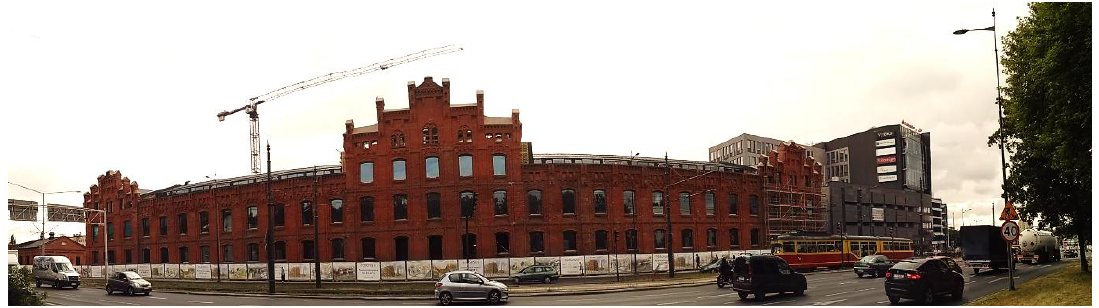
Figure 6. Main building of the former Vodka Monopoly in Łódź during construction works.